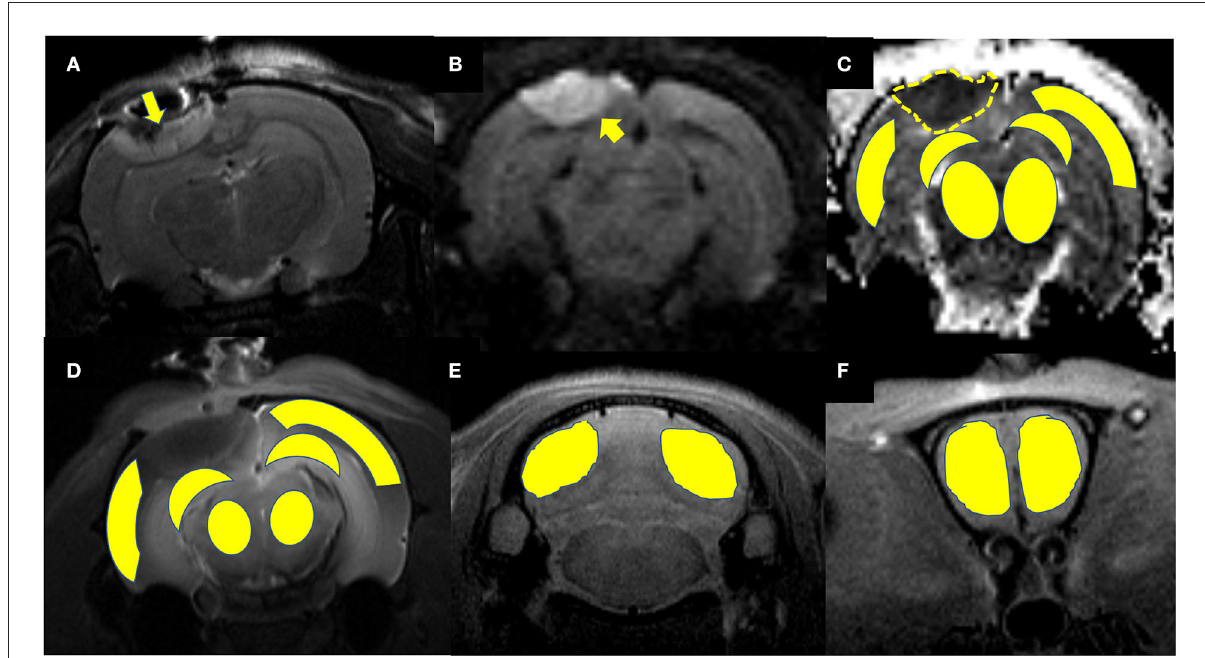
FIGURE2 Representative images describing the creation of regions of interest (ROIs) for obtaining signal intensity (SI) changes before and after intrathecal contrast agent delivery and for obtaining the diffusivity of the brain subregions before and after temperature management. (A) Coronal T2WI and (B) axial DWI are used as a reference to direct the ROIs creation in the brain subregion on T1WIs and ADC maps. A traumatic lesion (yellow arrow) and bilateral cortex, hippocampus, and thalamus can be visualized. (C) Depicts the diffusivity of traumatic lesions and subregions obtained from the ADC map. The yellow dashed line defines the area of edema as marked manually by an independent observer. The area measurement on a series of slices was followed by calculating edema volume by defined slice thickness. (D) The signal intensity change after Magnevist delivery is obtained from the brain subregion, including bilateral cortex (ROI in injured site excludes the lesion), hippocampus, thalamus, and (E) cerebellum, and (F) olfactory bulb on coronal T1WI sections.